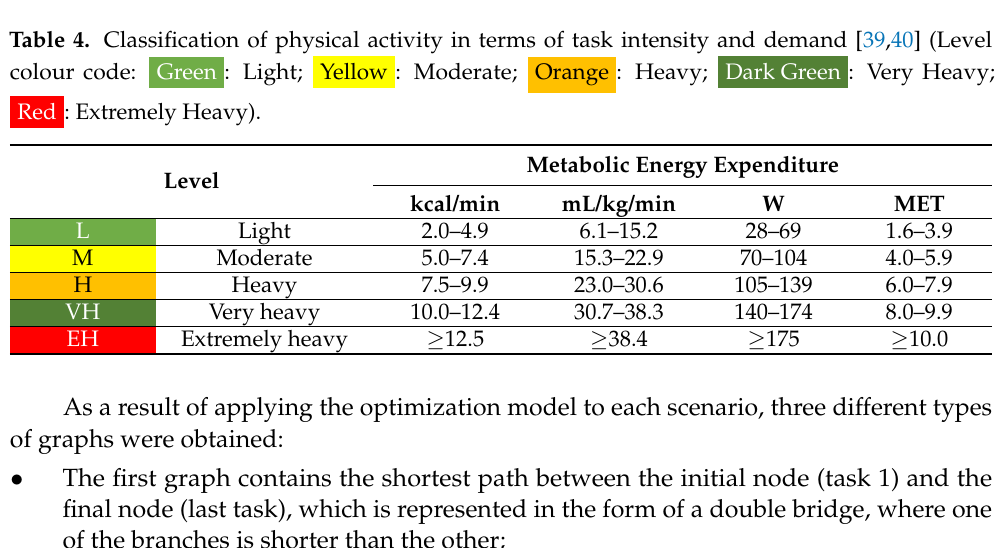
Table 4. Classification of physical activity in terms of task intensity and demand [39,40] (Level colour code: Green : Light; Yellow : Moderate; Orange : Heavy; Dark Green : Very Heavy; Red : Extremely Heavy). Metabolic Energy Expenditure Level kcal/min mL/kg/min W MET L Light